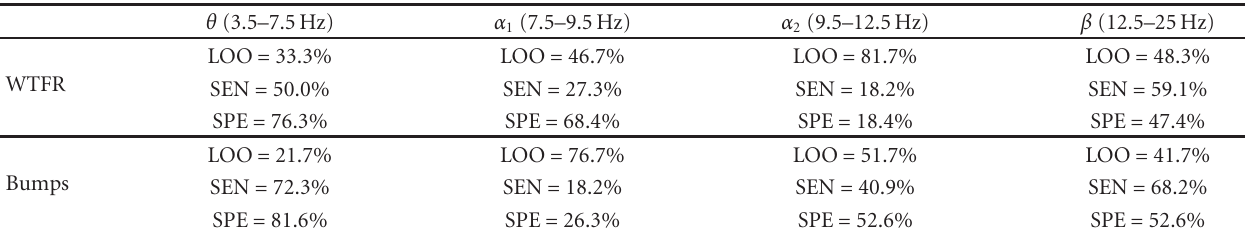
Table 1: LDA results, for WTFR and Bump amplitude. LOO = Leave-one-out validation error (classificationerror). SEN = sensitivity. SPE = specificity. In both cases, the best discriminating frequency range is in the theta range. Classification, sensitivity, and specificity are improved by bump